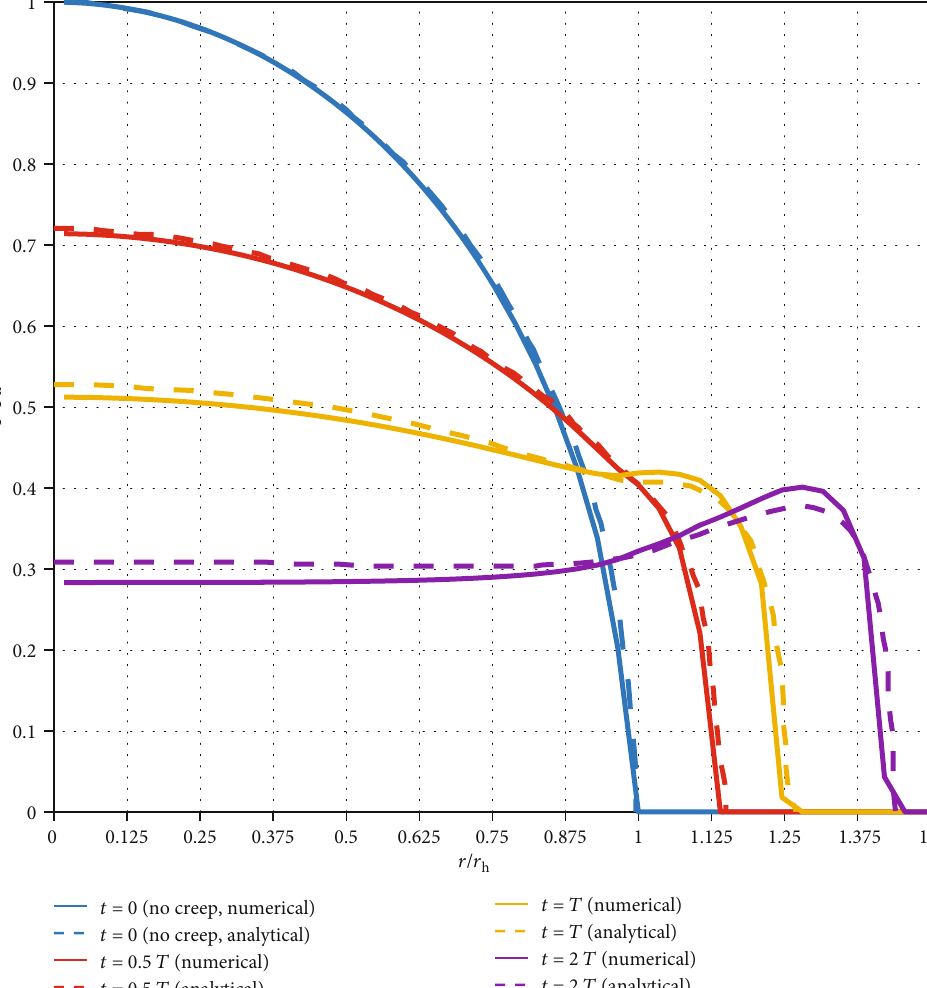
represents h represents the radius of the h